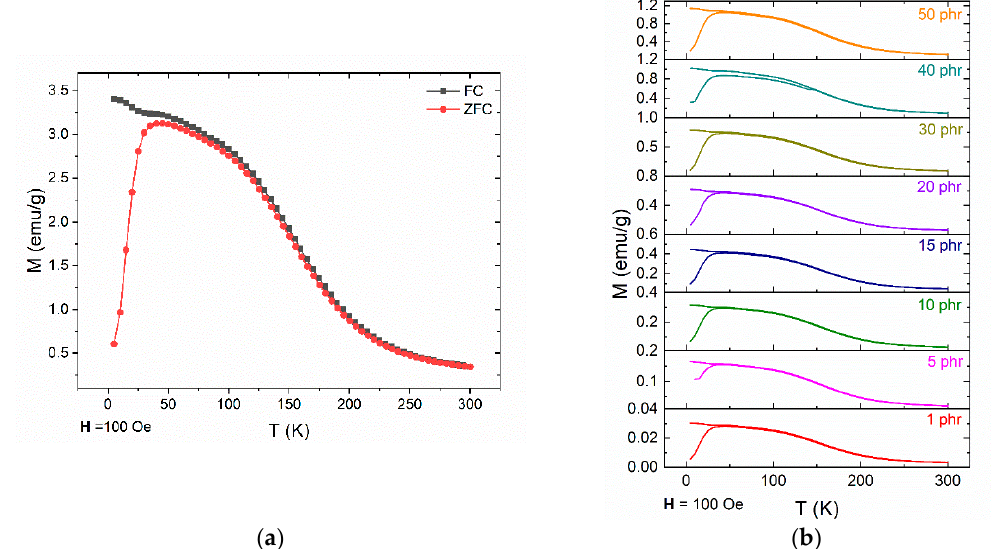
Figure 9. The ZFC and FC magnetization curves for ( a ) ZnFe 2 O 4 nanopowder and ( b ) nanocomposites